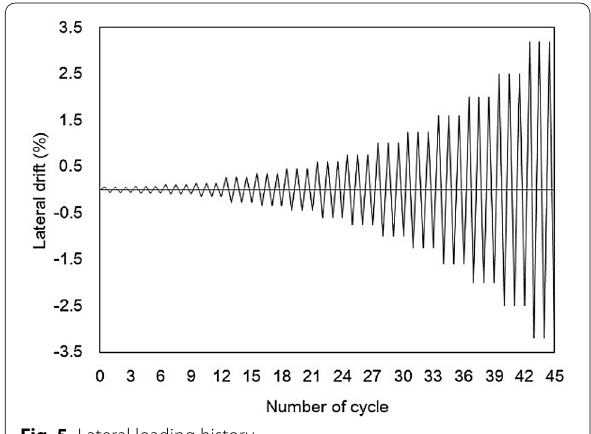
Fig. 5 Lateral loading history.